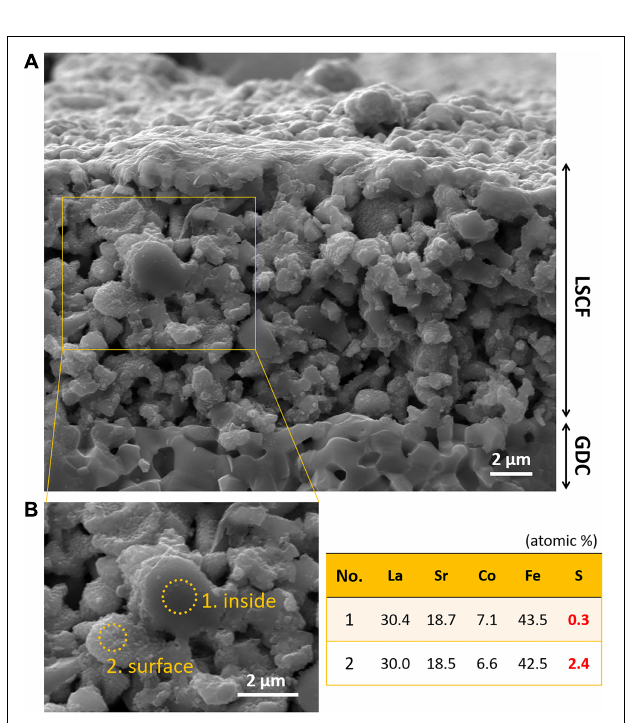
FIGURE 5 | (A) SEM image of the cross section of the LSCF/GDC cell exposed to an alternating atmosphere of air and 4 ppm SO 2 ( g ) for ∼ 360 h at 700 ◦ C during the electrochemical test. (B) Elemental composition (La, Sr, Co, Fe, and S) of LSCF particles measured by EDS (on the core and